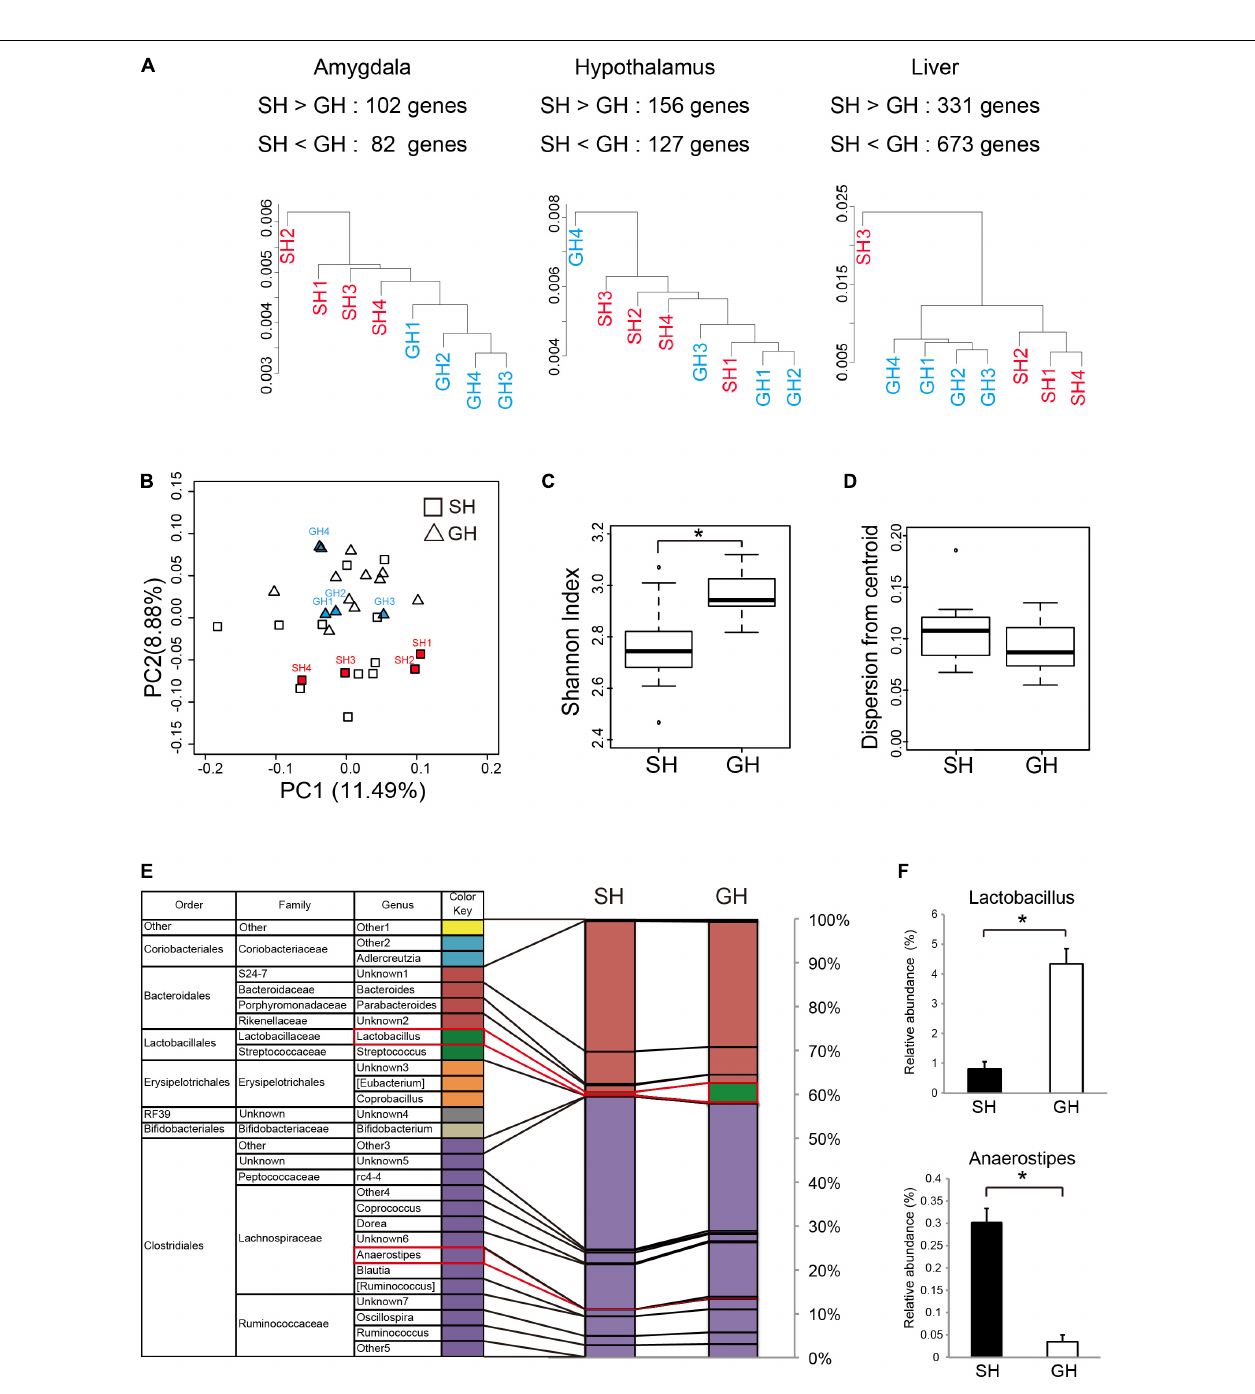
FIGURE 3 | Effect of housing condition on the tissue transcriptome and the gut microbiome. (A) Cluster analysis of the genes expressed in the amygdala, the hypothalamus, or in the liver. Protein coding sequences with the expression levels of more than 0.3 reads per kilobase of exon per million (RPKM) mapped reads were analyzed. The number of differentially expressed genes (SH > GH or SH < GH) was calculated from the statistical comparison by DEseq2 ( n = 4 for each group). (B) Principal coordinate analysis (PCoA based on Bray-Curtis distance) of the cecal microbiome at the genus level. Mice used for correlation analysis were marked by the abbreviation same as in (A) ( n = 15 for each group). (C) Alpha-diversity analysis of cecal microbiome ( n = 15 for each group). The Shannon index of the SH group was significantly lower than that of GH group, p = 2.40 × 10 - 4 . (D) The dispersion from each centroid was calculated from Bray-Curtis distance of each group. No significant difference was observed among the groups ( n = 15 for each group). (E) The composition of cecal bacterial genera was analyzed by 16s rDNA amplicon sequencing ( n = 15 for each group). Names in parenthesis were temporarily assigned to bacteria in the reference data set (Rainey and Janssen, 1995). (F) Significant between-group differences (*) were detected in the abundances of Lactobacillus (Lactobacillales, Lactobacillaceae, SH < GH, p = 8.98 × 10 - 4 ), and Anaerostipes (Clostridiales, Lachnospiraceae, SH > GH, p = 2.42 × 10 - 4 ). The color code for the bacteria species was represented at the genus level. *Significant differences were detected by unpaired t -test ( p <